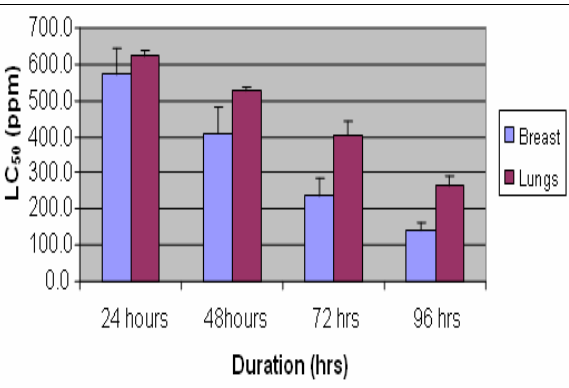
Figure 4: LC values of 2,4 DNT for breast and lung 50 cells exposed at various times.